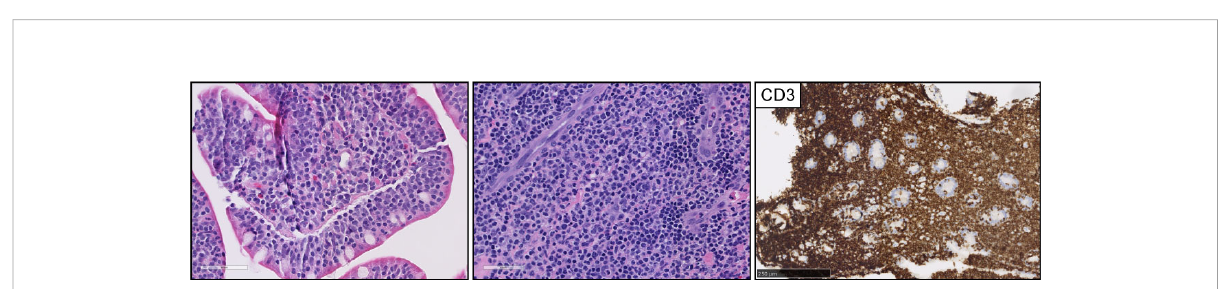
FIGURE 3 Intestinal T-cell lymphoma, non-otherwise speci fi ed (ITCL-NOS). H&E pictures demonstrate dense in fi ltrates of medium to large, atypical lymphocytes with epitheliotropism. The in fi ltrates were composed of CD3-positive T-cell lymphocytes with (not shown) aberrant CD7 and CD5 loss and negative expression of